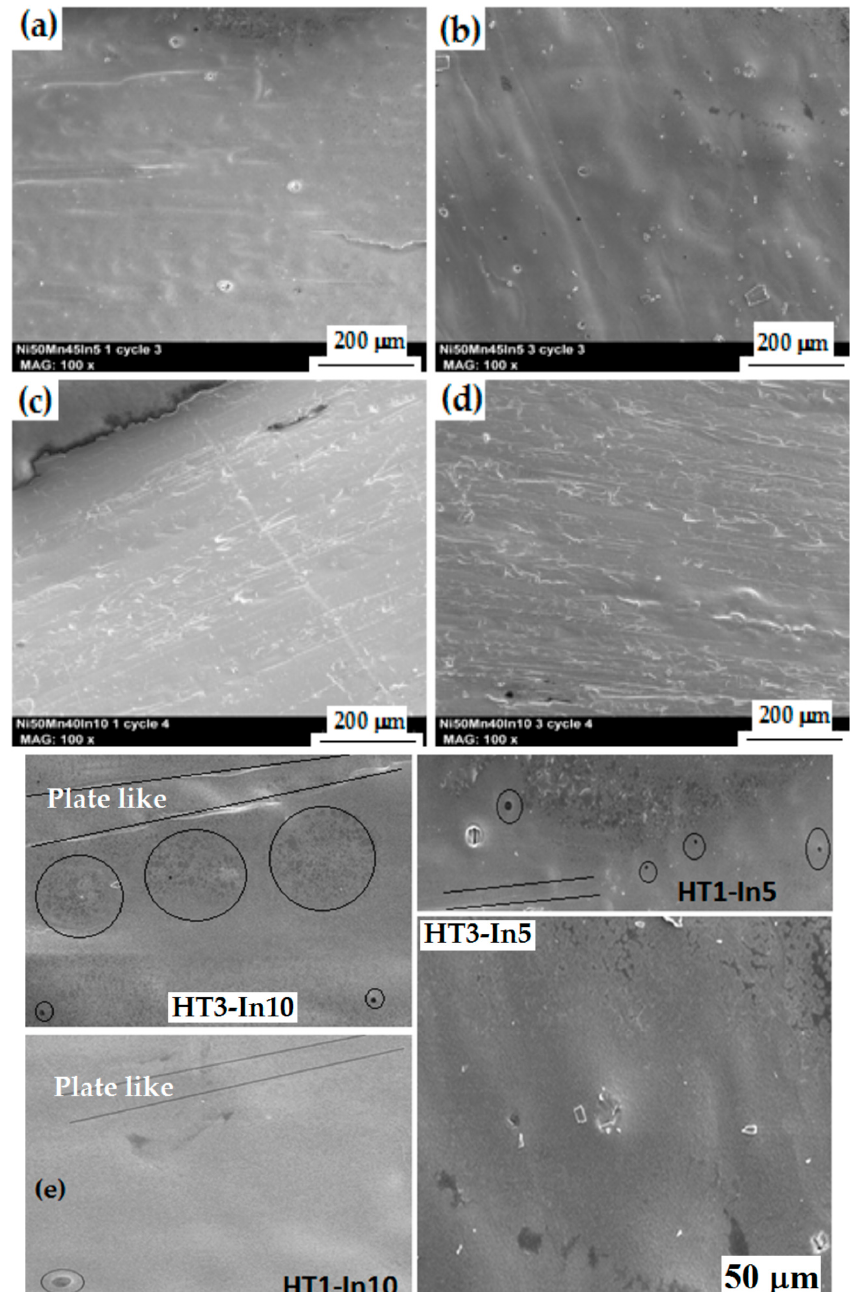
Figure 5. SEM micrographs after one and three heating/cooling cycles in the In-5 and In-10 samples: ( a ) HT1-In5; ( b ) HT3-In5; ( c ) HT1-In10; and ( d ) HT3-In10 ribbons. The enlargement parts ( e ) reveal different